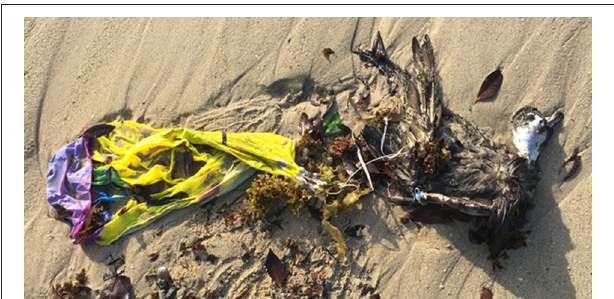
FIGURE 3 | Adult Flesh-footed Shearwater entangled in a mylar foil balloon, Coogee Beach, New South Wales, 7 April 2018 (photo credit: Marina